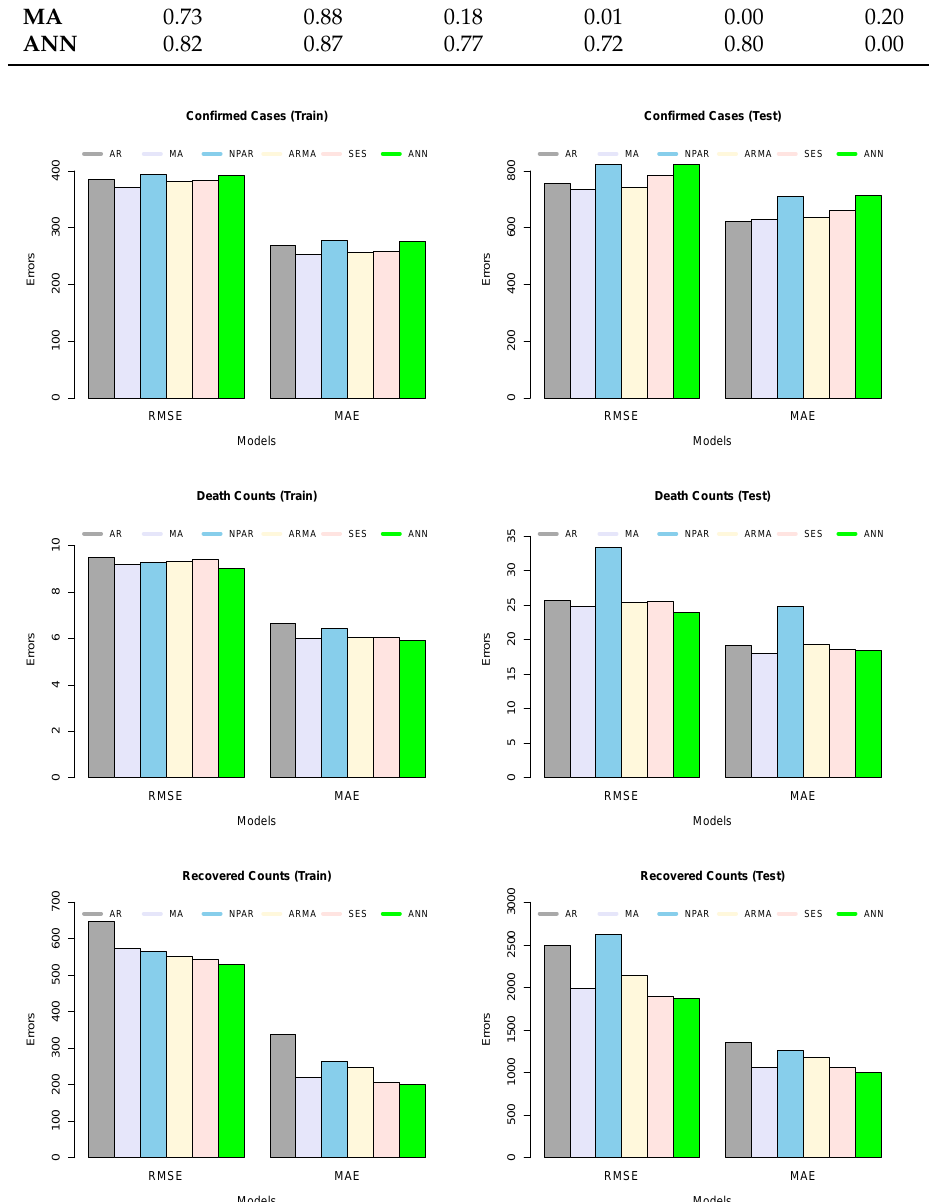
Figure 4. Barplot: RMSE and MAE for confirmed cases, deaths, and recovered cases; Model Estima- tion/Train (left column) , Out-of-Sample/Test (2nd column) for all